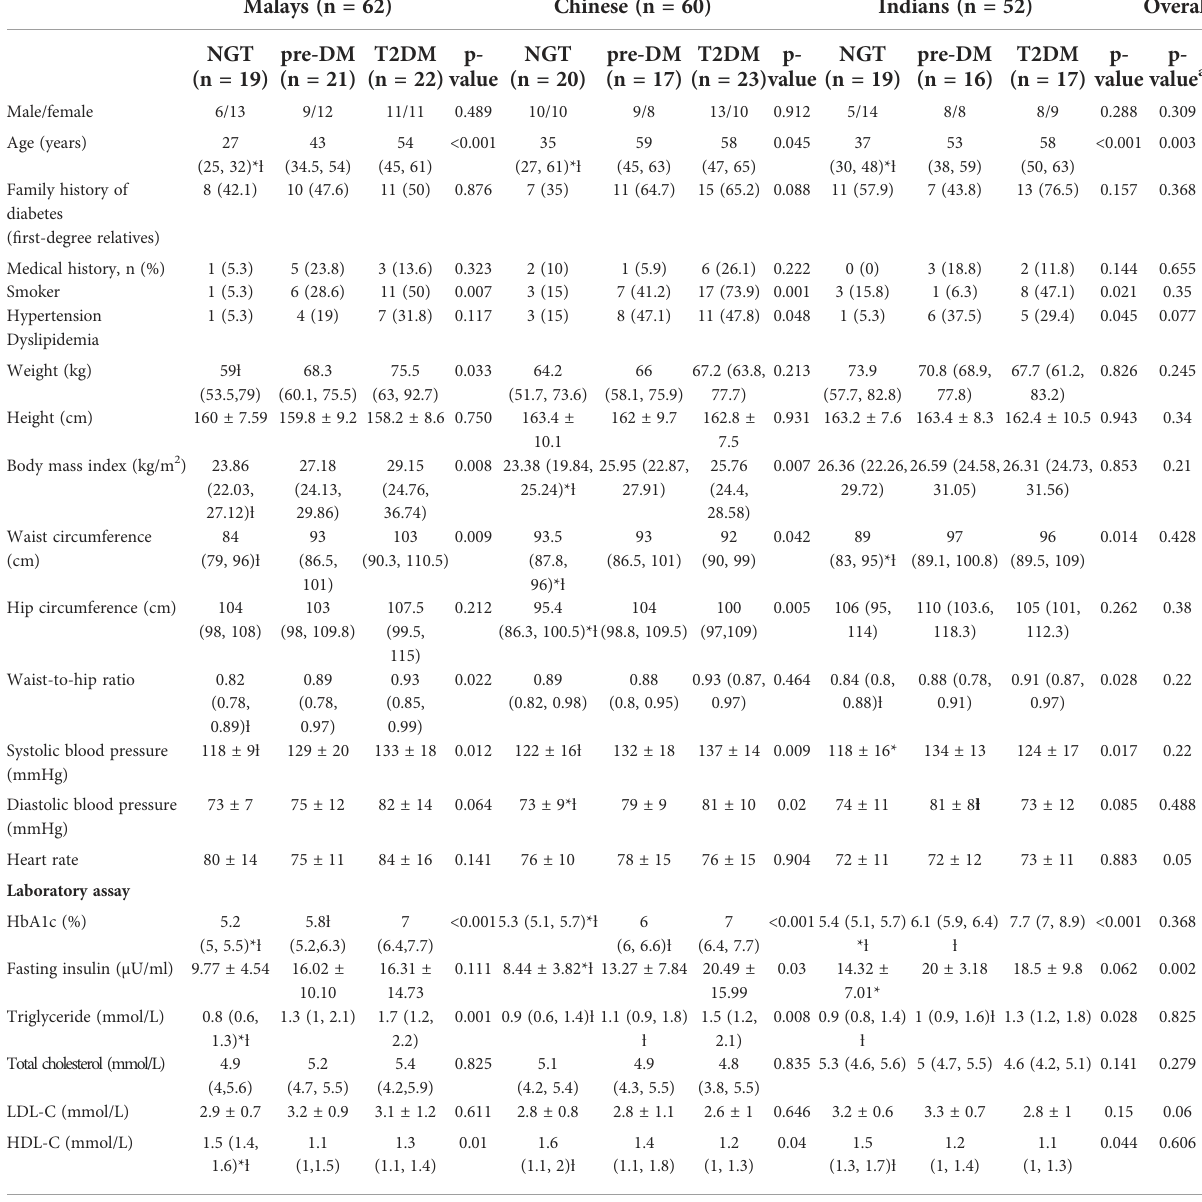
TABLE 2 Clinical characteristics of Malay, Chinese, and Indian subjects with NGT, pre-DM, and